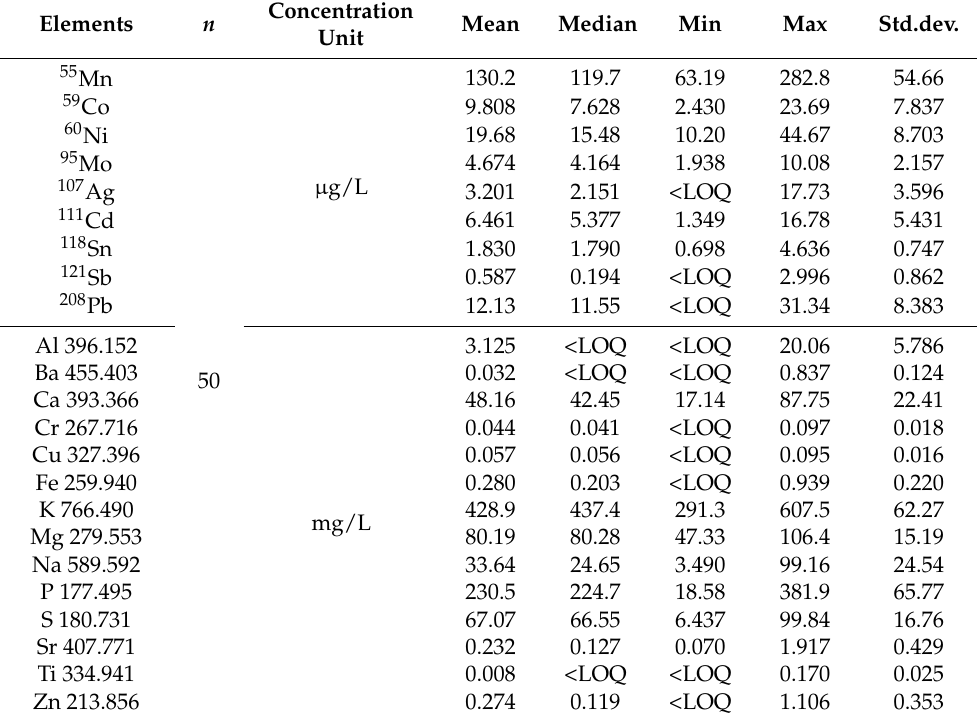
Table 2. Basic statistics for determined elements for all beer samples ( n = 50) [mg/L].